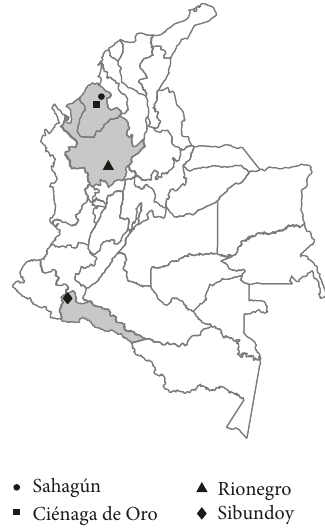
Figure 1: Colombian regions